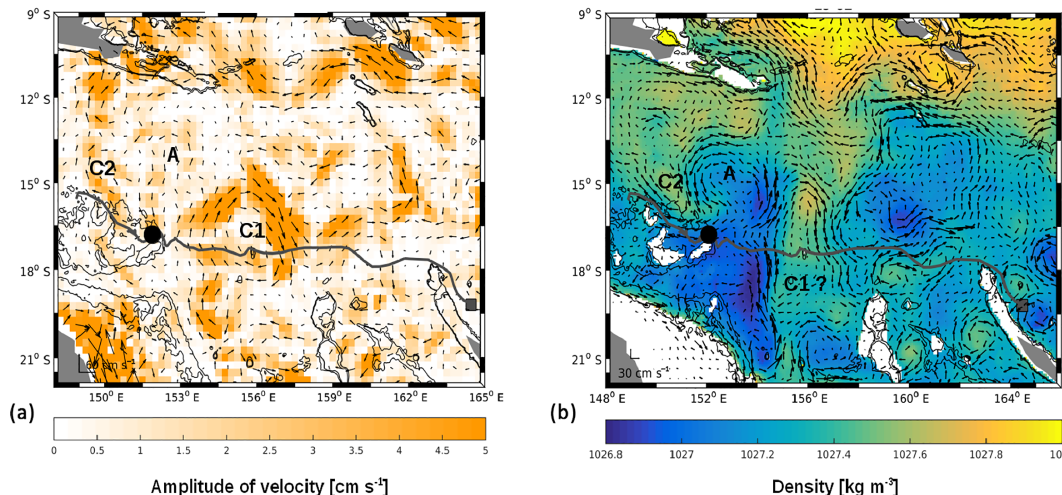
Figure 5. (a) Amplitude of surface geostrophic velocity on 29 February 2016 during O2, calculated from AVISO product; (b) density and velocity field at 300m depth on 29 February 2016 during O2, calculated from the HYCOM re-analysis. The gray line corresponds to the full trajectory of float 656, and the black point to the location of the float at the stated date. The black lines correspond to the bottom topography at 300 and 1000m depth.